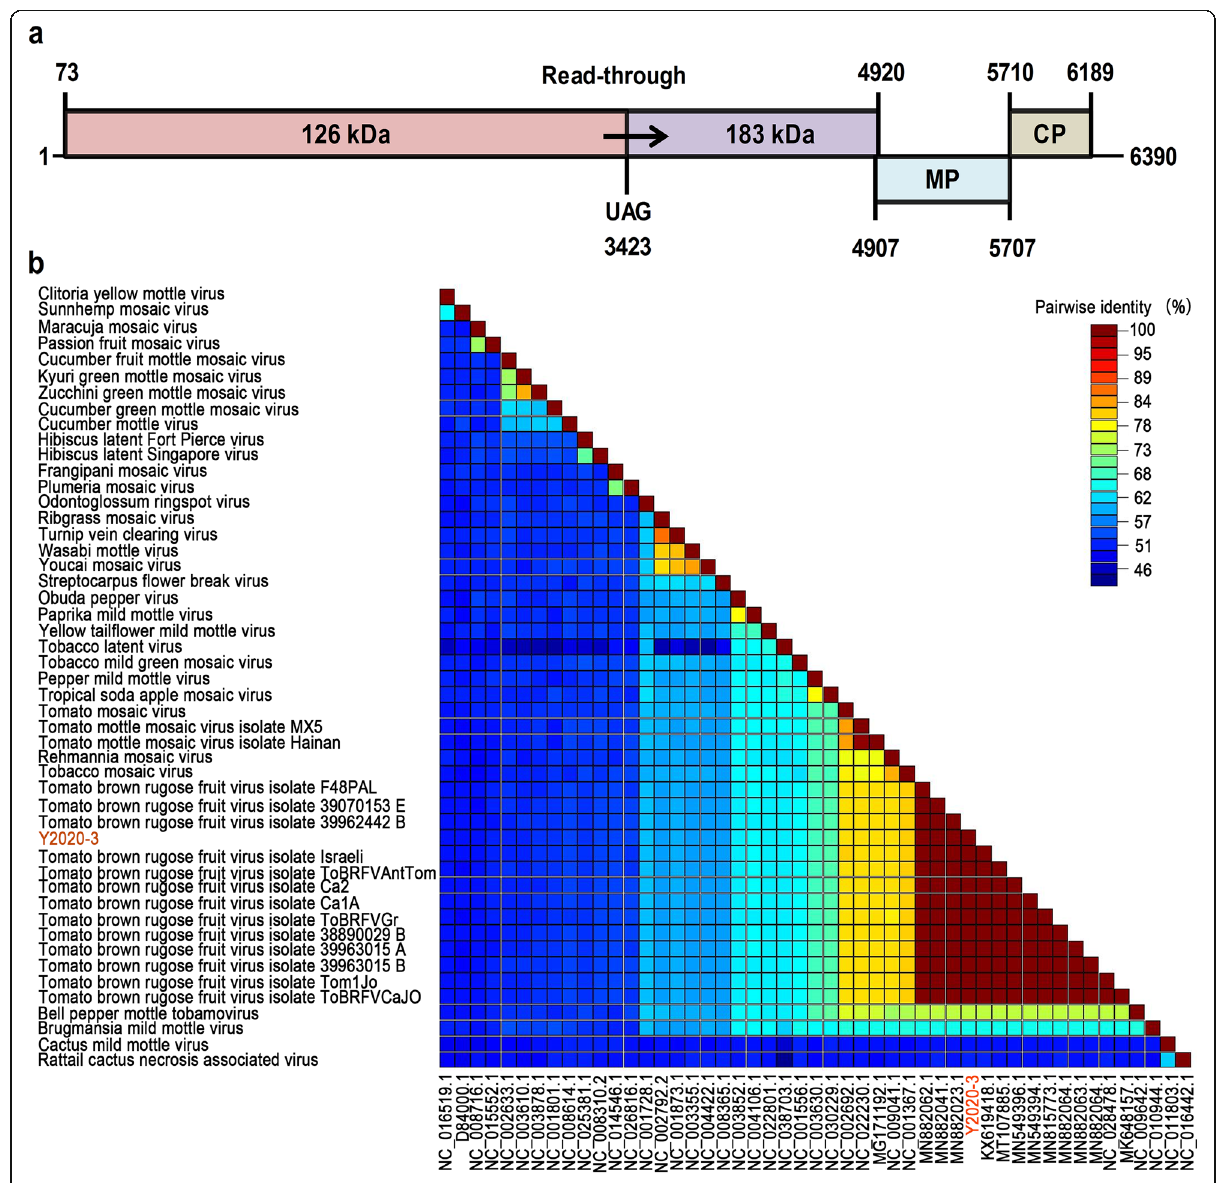
Fig. 2 Genome organization and pairwise identity of ToBRFV. a Diagram depicting the genome organization of ToBRFV. The rectangles correspond to the predicted protein products of the four open reading frames. Positions are marked at the ends. b Pairwise identity matrix of the complete genome sequences of ToBRFV and other representative tobamoviruses generated using Sequence Demarcation Tool version